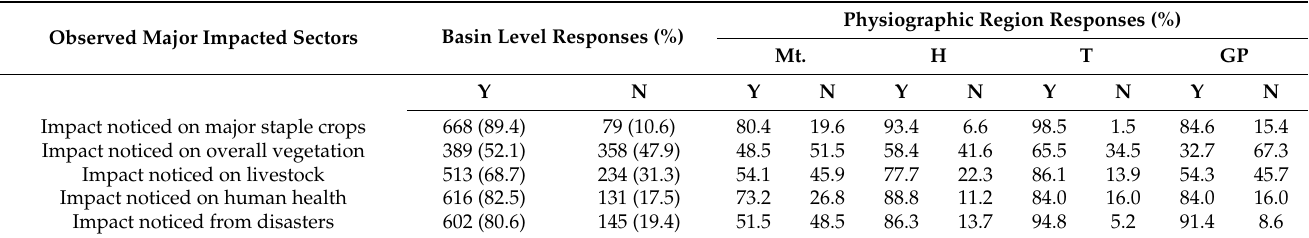
Table 3. The observed impacts of climate change by the local respondents’ in the various sectors for the trans-boundary KRB. Observed Major Impacted Sectors